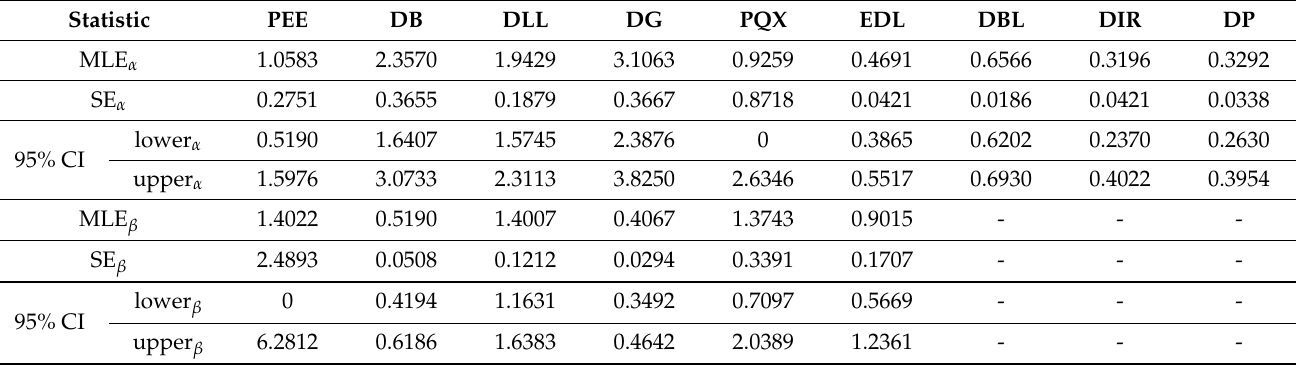
Table 8. Corn borer data: MLEs, SEs and CIs.